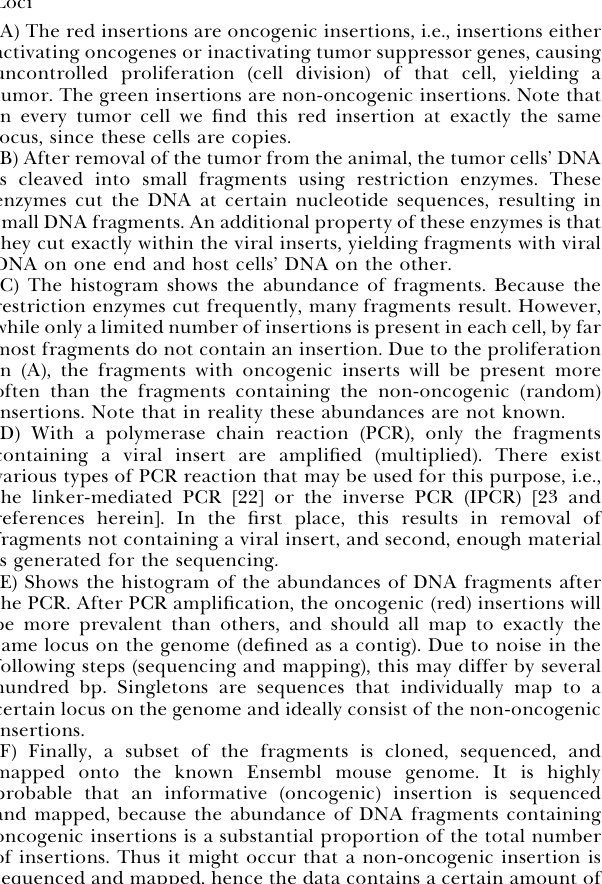
Figure S1. Schematic—and Idealized—Overview of the Tumor Development Process and the Procedure to Acquire the Insertion Loci